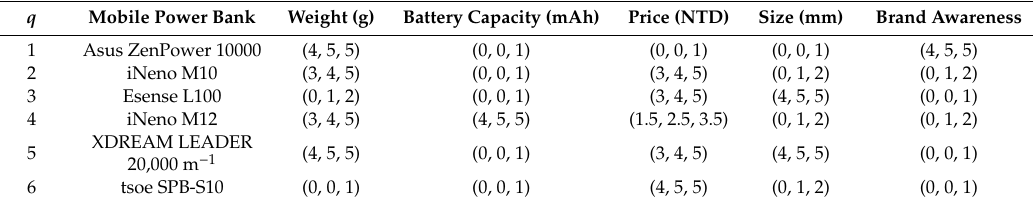
Table 3. Evaluation results.